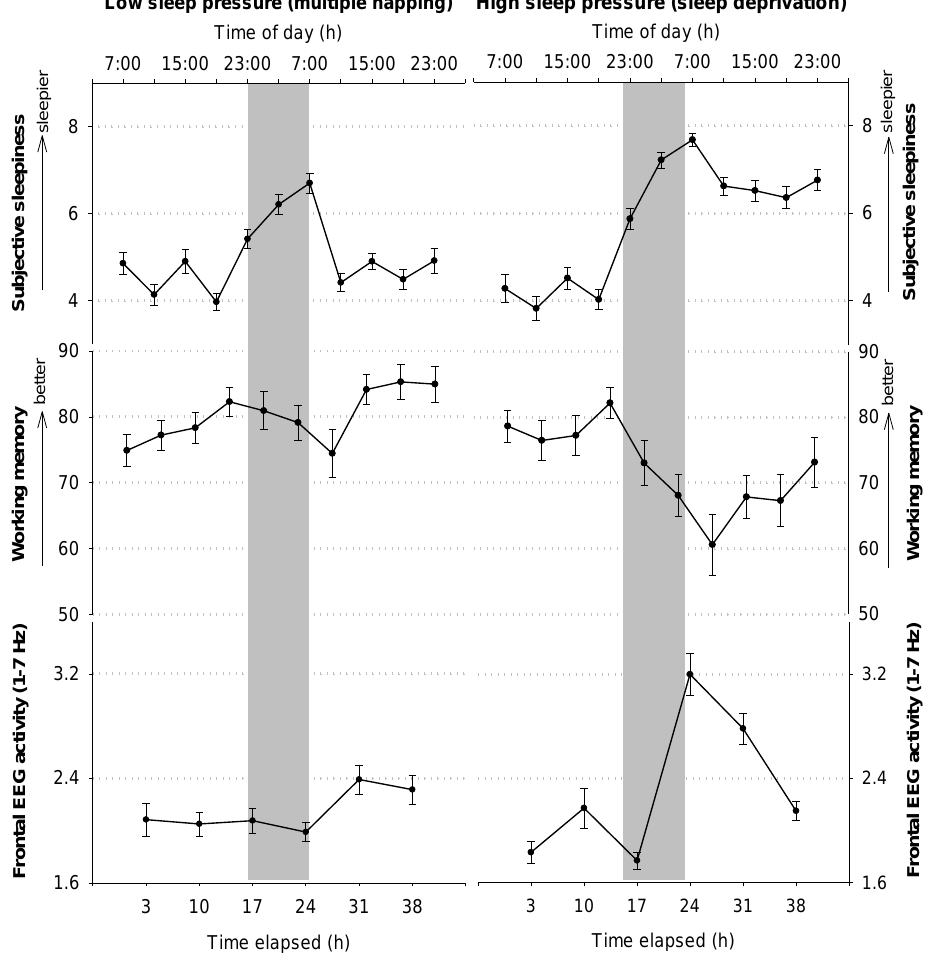
Figure 3. Circadian and homeostatic influences on subjective sleepiness, WM performance, and waking EEG. Values assessed during a low sleep pressure condition (NP) are depicted on the left panel, and mirror circadian influences under rather low sleep pressure conditions. On the right side, the impact of rising sleep pressure during night- and daytime is illustrated, as these values were assessed during a SD of 40 h. The grey bars indicate nighttime. Subjective sleepiness was assessed by a questionnaire (Karolinska Sleepiness Scale [53]), WM performance by an n-back task (depicted is the percentage of hits). The waking EEG was analyzed over three frontal derivations (F3, F4, FZ). Please see [12,49] for further information on data assessments and study protocol.